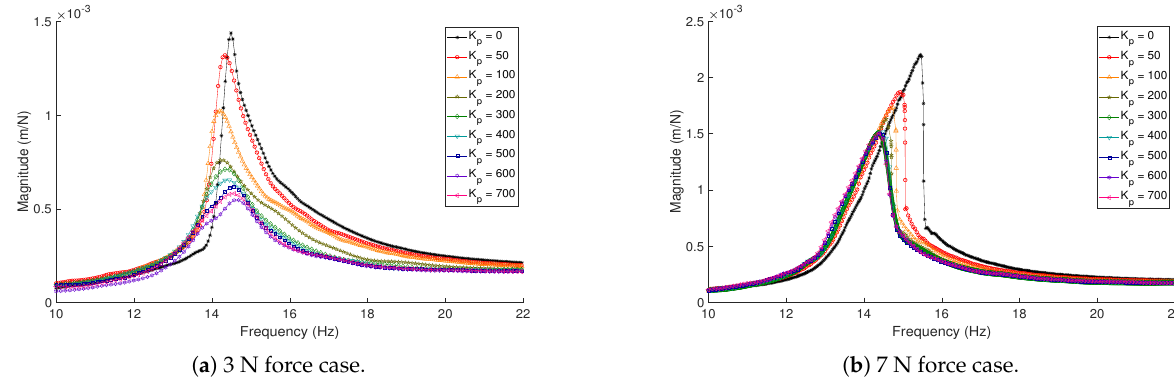
Figure 6. Controlled response of the structure excited at ( a ) 3 N of force and ( b ) 7 N of force sweeping upwards through the frequency range surrounding the first resonance frequency for varying gain